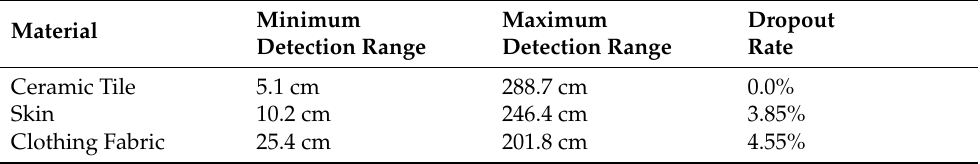
Table 2. Comparison of reflected materials from benchmark test recordings. From left to right: ceramic tile, skin from the hand, torso covered by